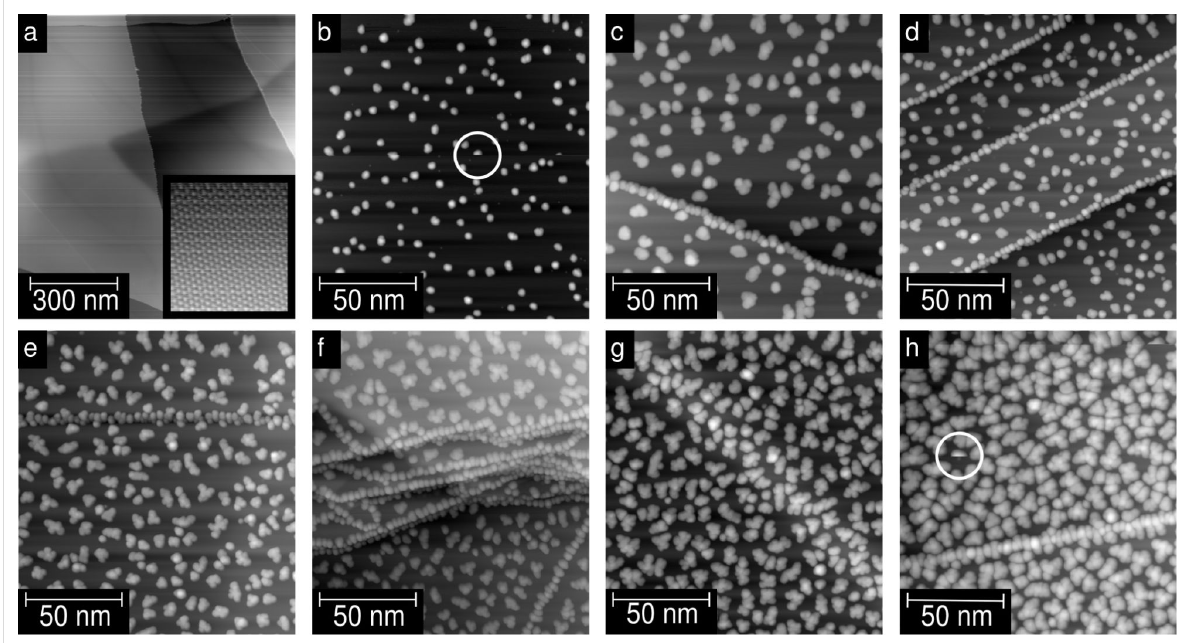
Figure 1: Evaporation time and flux dependence of the growth of the Ni-clusters without further annealing. STM topographic images of (a) freshly cleaved HOPG. The image shows a large-scale scan ( V = 2 V; I = 0.2 nA), the inset shows atomic resolution ( V = 0.3 V; I = 0.5 nA). (b–h) Evapo- rated Ni clusters on HOPG ( V = 1 V; I = 0.2 nA). Evaporation parameters: (b) flux ≈ 50 nA, time = 30 s → Π f × t = 1.5 μ As; (c) ≈ 15 nA, 300 s, 4.5 μ As; (d) ≈ 100 nA, 50 s, 5.0 μ As; (e) ≈ 50 nA, 180 s, 9.0 μ As; (f) ≈ 100 nA, 100 s, 10.0 μ As; (g) ≈ 145 nA, 100 s, 14.5 μ As; (h) ≈ 150 nA, 160 s, 24.0 μ